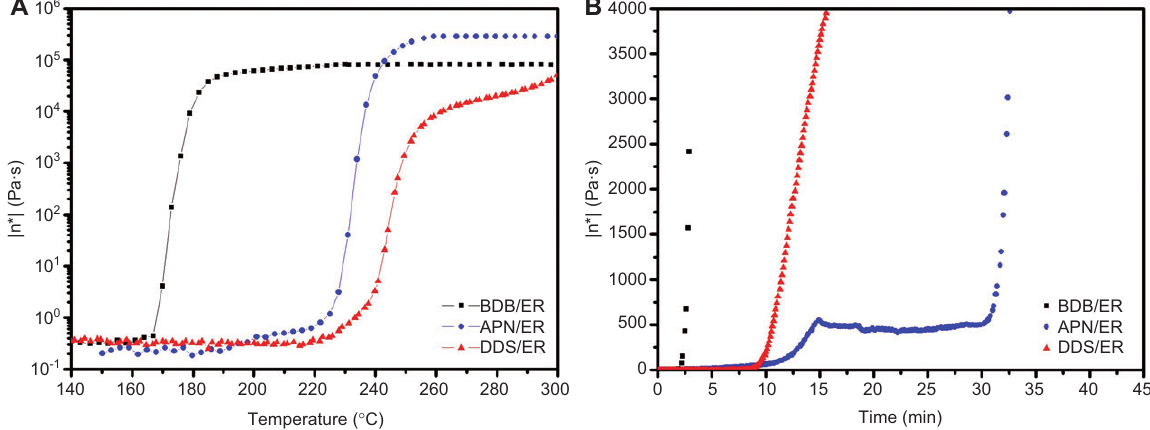
Figure 3 Complex viscosity ( η *) for the amine/epoxy blends: (A) as a function of temperature; (B) as a function of time at 200 °